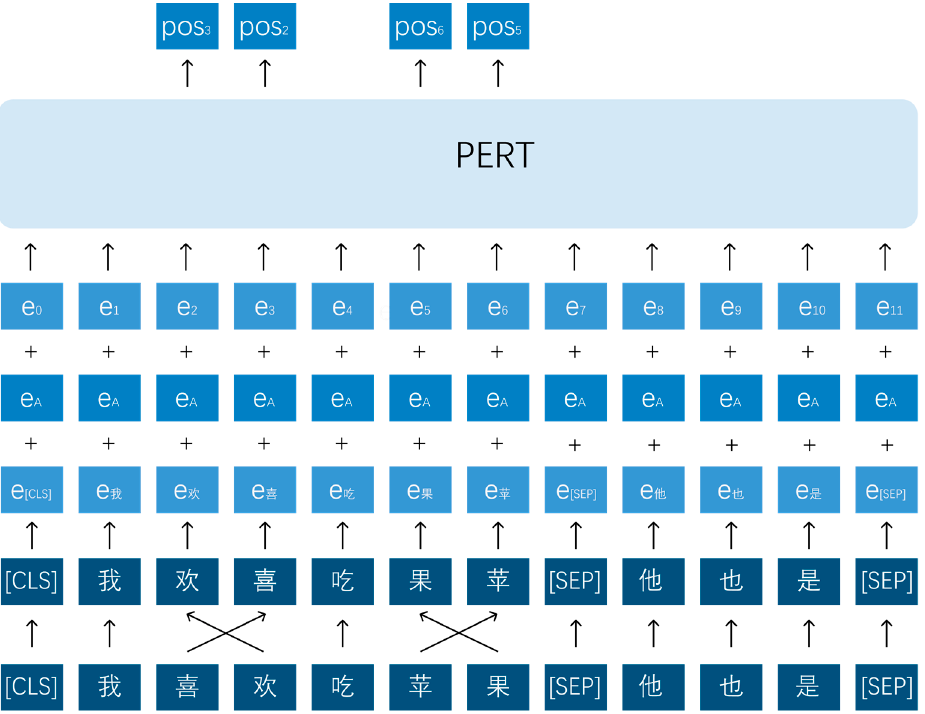
Figure 5. Neural architecture of PERT. Example “ 我喜欢吃苹果 , 他也是 ” (this means ”I love eating apples, and so does he”).